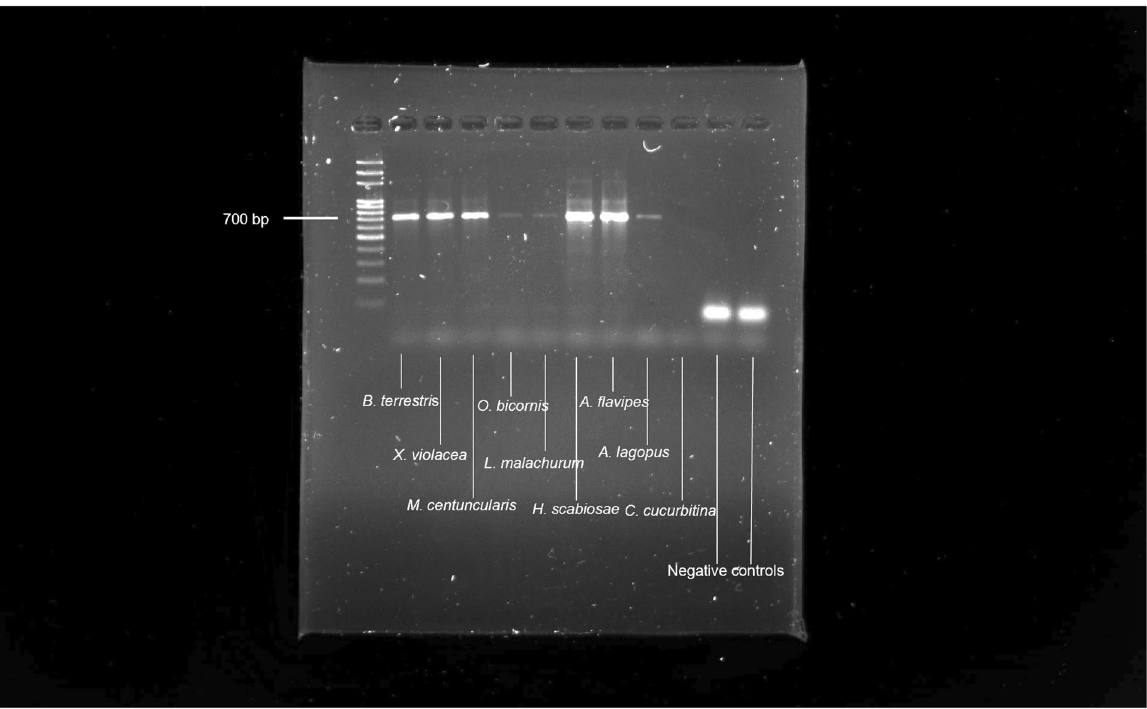
Figure 1. Gel electrophoresis of PCR performed on DNA amplified from the investigated bee species. As a negative control double distilled RNase-DNase-free water. Light bands also could mean low DNA